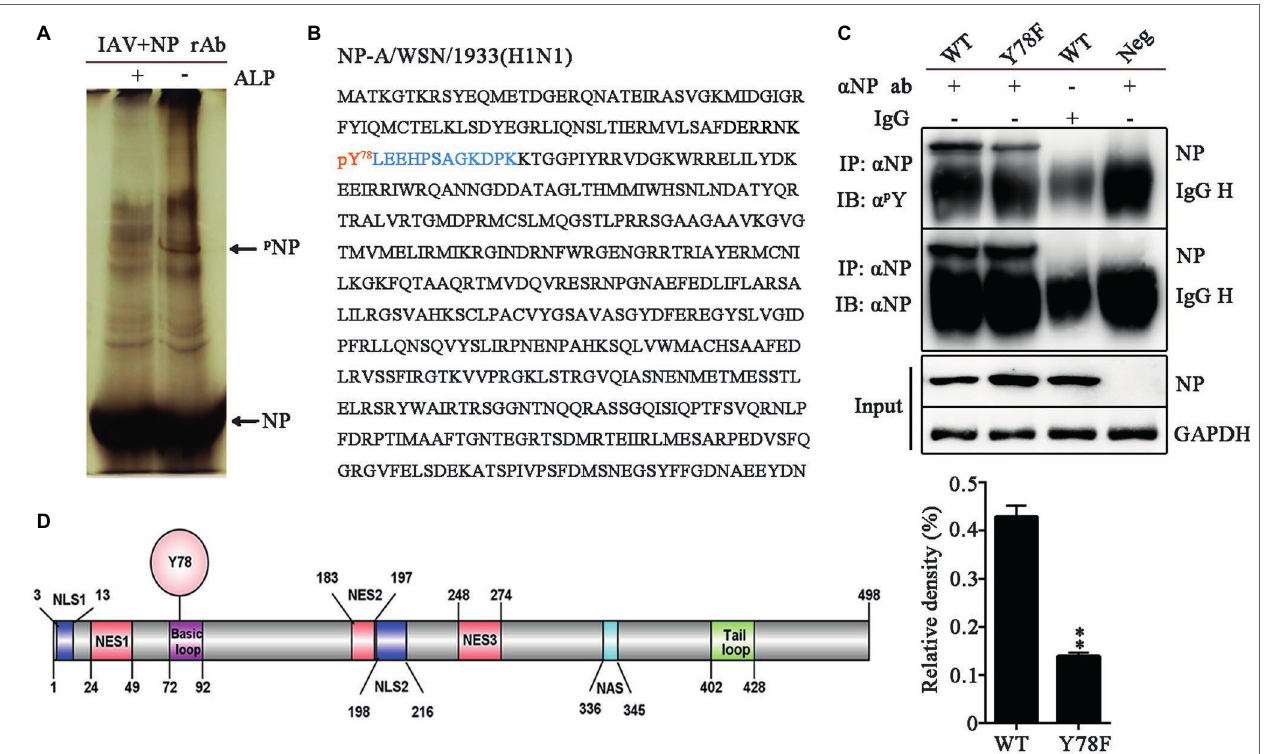
FIGURE 1 | NP Y78 is a conserved phosphorylation site. (A) The Phos-tag SDS-PAGE gel of phosphorylated NP immunoprecipitated with rabbit anti-NP antibody. The IAV (WSN)-infected 293 T cells were lysed in lysis buffer supplemented with complete protease inhibitor cocktail and a phosphatase inhibitor phosSTOP. The extra band in untreated cells was considered to be a phosphorylated band compared to alkaline phosphatase (ALP)-treated cells. The band was digested and subjected to LC-MS/MS analysis. The locations of NP and phosphorylated NP bands ( p NP) are indicated by arrows. (B) LC-MS/MS analysis of the phosphorylated band. The band was identified as the IAV NP. The identified polypeptide sequence is indicated in blue, and the phosphorylated tyrosine site is indicated in red. (C) Detection of tyrosine-phosphorylated NP. A549 cells infected with viruses (WT or Y78F WSN, MOI = 1) were lysed at 12 h.p.i. and then were incubated with NP antibody and protein G agarose beads. The uninfected cells immunoprecipitated with anti-NP antibody and the infected cells immunoprecipitated with non-specific IgG served as controls. The immunoprecipitated NPs of the WT and Y78F WSN viruses were detected using anti-NP antibody ( α NP) or anti-p-Tyr antibody ( α p Y) (top). The relative density of phosphorylated NP was normalized to total NP (below). Data are shown as mean + SD ( n = 3). Difference between WT and Y78F mutant viruses was tested using unpaired Student’s t -test. ** p < 0.01. (D) Schematic diagram of NP functional domains, including Y78, nuclear localization sequence (NLS), nuclear export sequence (NES), nuclear aggregation sequence (NAS), basic loop and tail loop region.